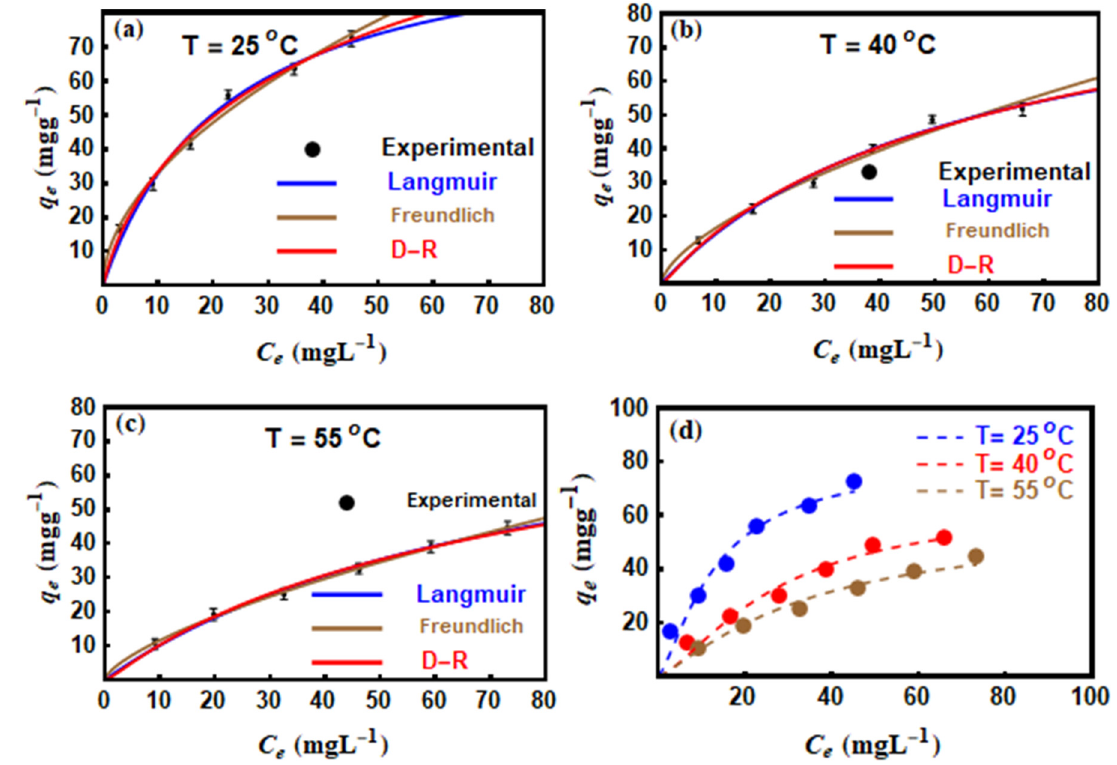
Figure 4. Isotherms of the adsorption of MO on adsorbent Mn-mica and their modeling with ( a – c ) traditional (i.e., Langmuir, Freundlich and D-R) and ( d ) statistical physics models.